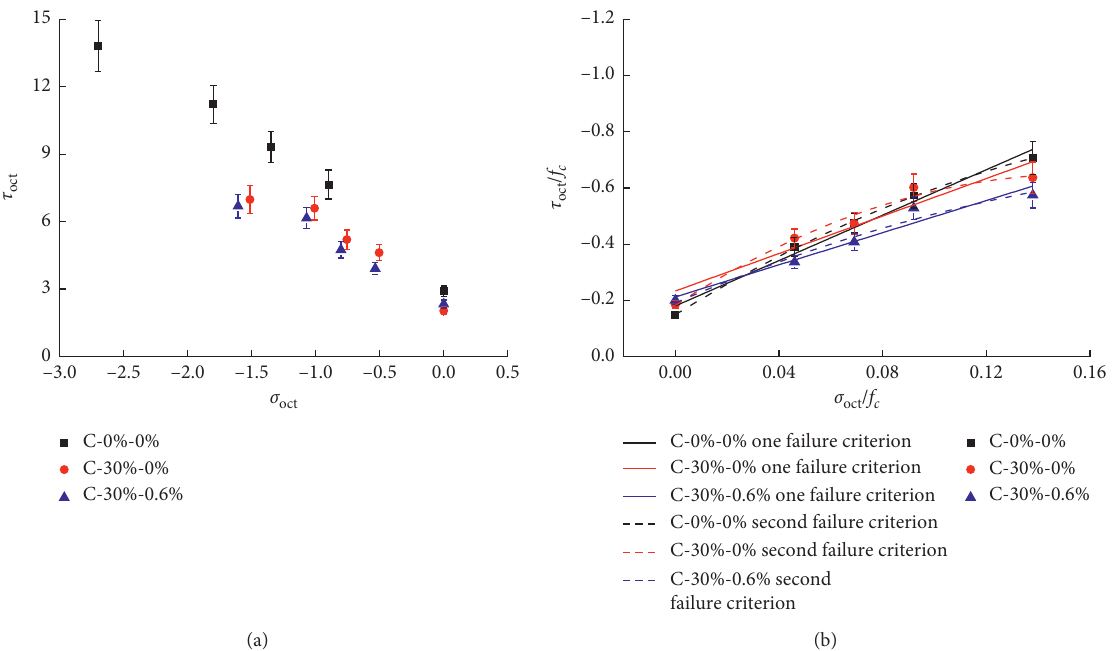
Figure 14: The octahedral space stress relationship of rubber fiber concrete. (a) Normal stress and shear stress. (b) Octahedral failure